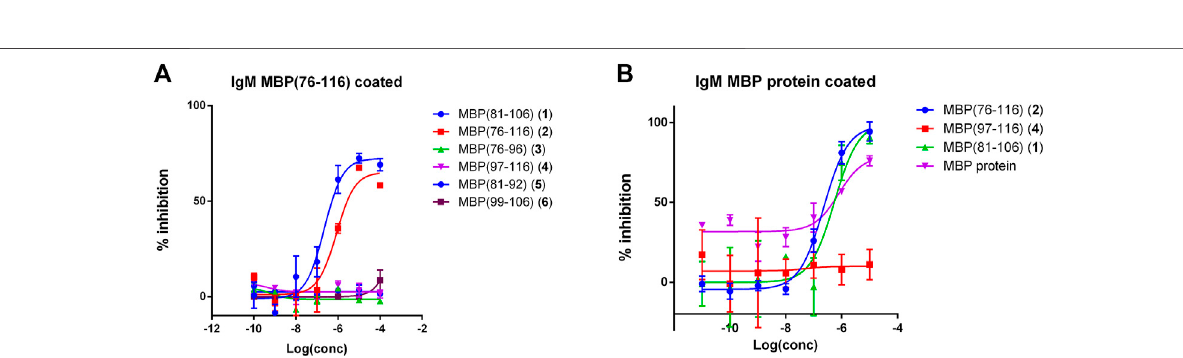
FIGURE 1 | Mean antibody titers to MBP peptide antigens for IgGs (A) and IgMs (B) of MS patient sera. IgM antibody responses of the MS serum to the coated peptides MBP (81 – 106) (1) and MBP (76 – 106) (2) are plotted in red.